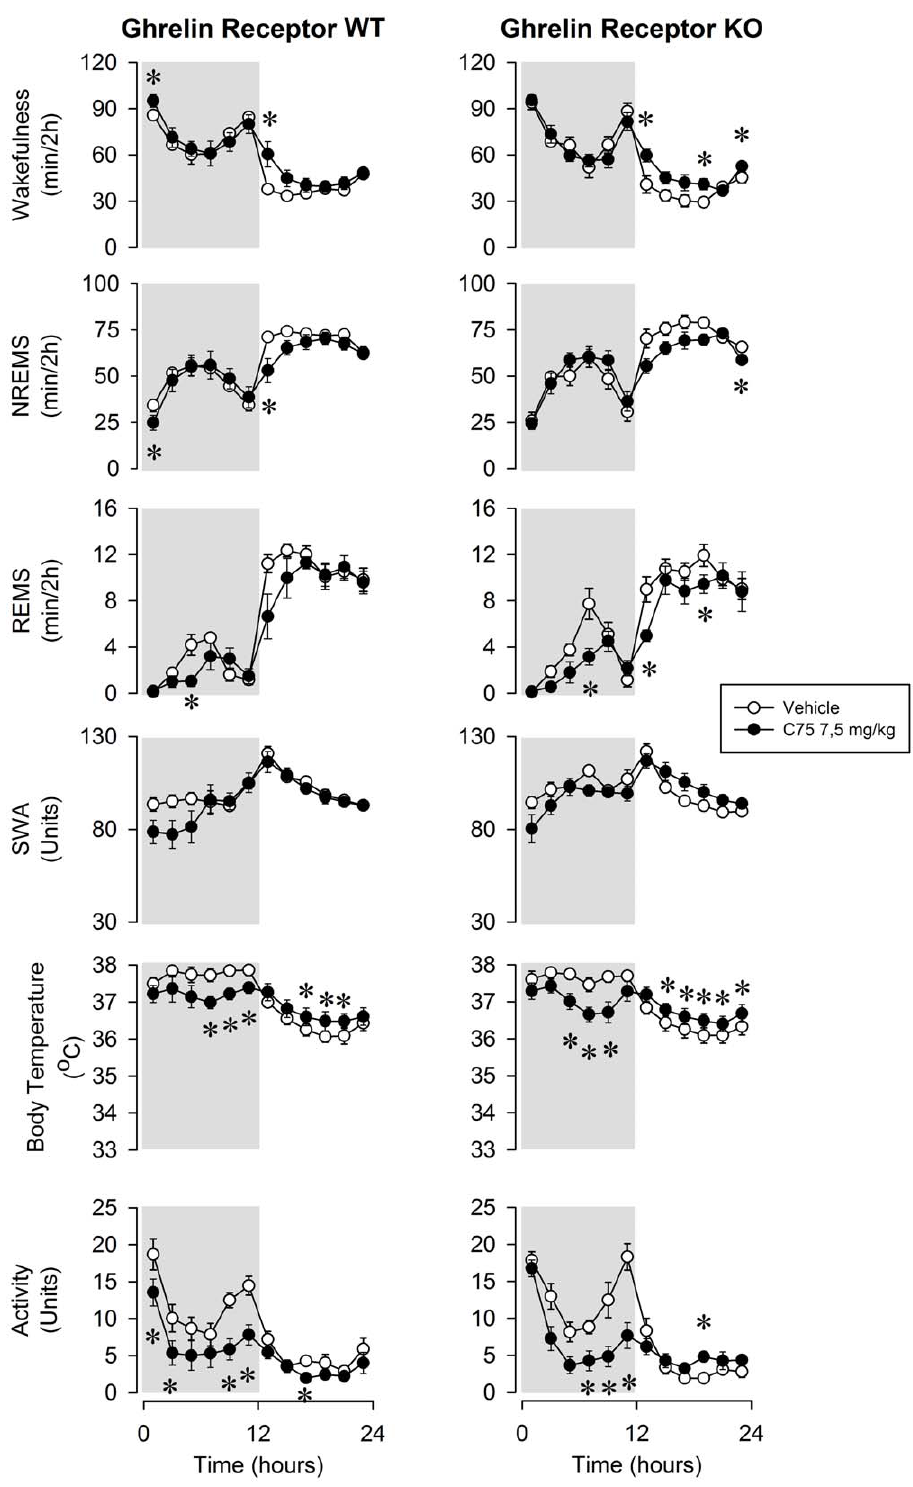
Figure 1. Wakefulness, non-rapid-eye-movement sleep (NREMS), rapid-eye-movement sleep (REMS), slow-wave activity of the electroencephalogram (SWA), body temperature and locomotor activity in ghrelin receptor wild-type (WT) and knockout mice (KO). Open symbols: vehicle injection, solid symbols: 7.5 mg/kg C75 intraperitoneally (ip). Data were calculated in 2-h time blocks. Time ‘‘0’’: time of the injections. Activity is expressed as the percent of the total 24-h activity on the vehicle day. Dark shaded areas: dark period. Error bars: standard error. Asterisks denote significant differences between control and treatment days ( post hoc paired t-test).